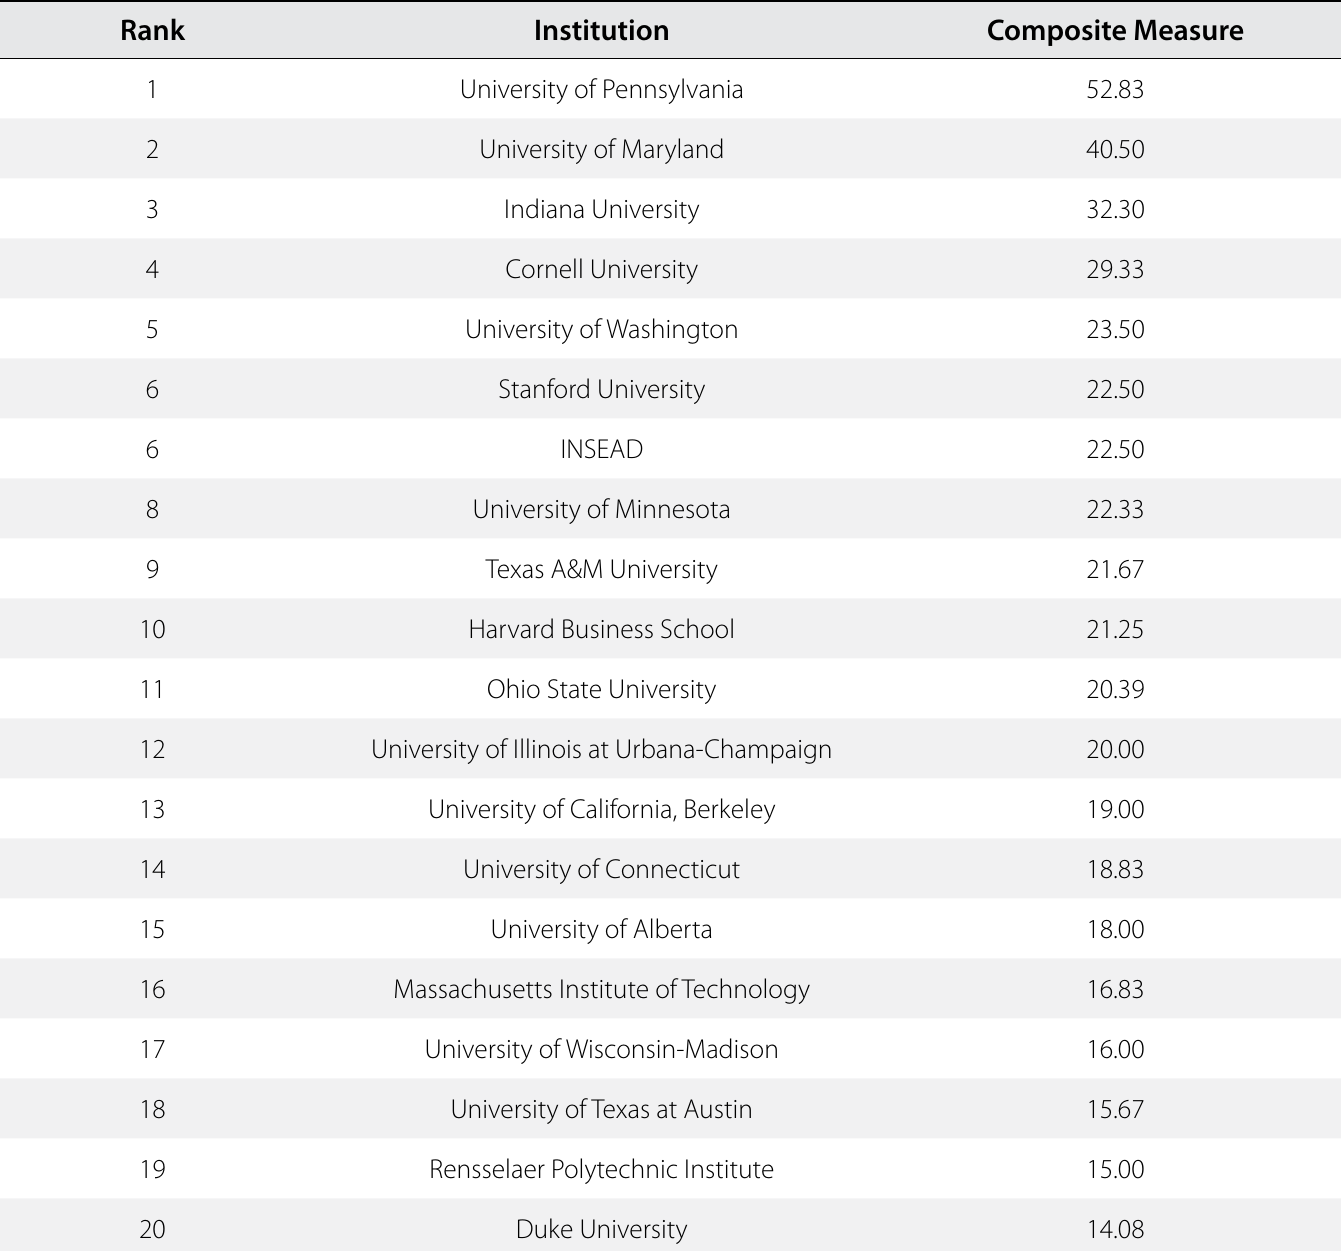
Table 11. Top Institutions Ranked by Composite Measure